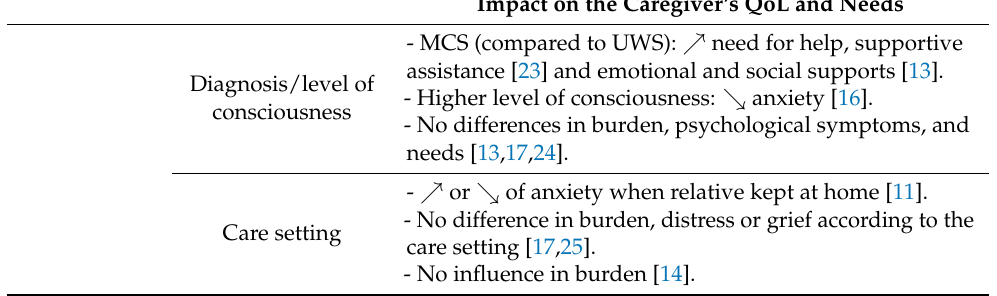
Impact on the Caregiver’s QoL and Needs